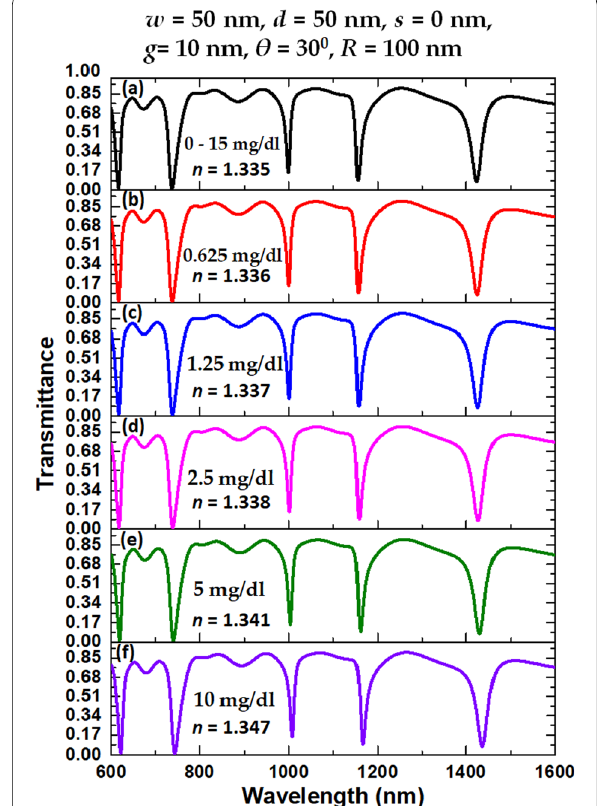
Fig. 7 Transmittance spectra of case 3 structure at different urine glucose level samples, i.e., a 0–15 mg/dl ( n ( n 1.336), c 1.25 mg/dl ( n = dl ( n 1.341) and f 10 mg/dl ( n =